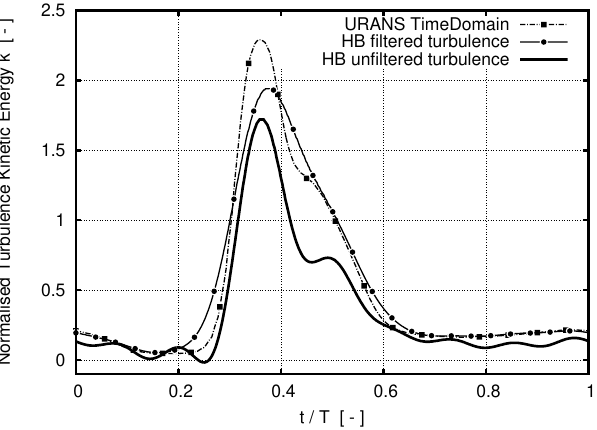
Figure 4. Wake of turbulence kinetic energy k downstream of a LPT stator vane